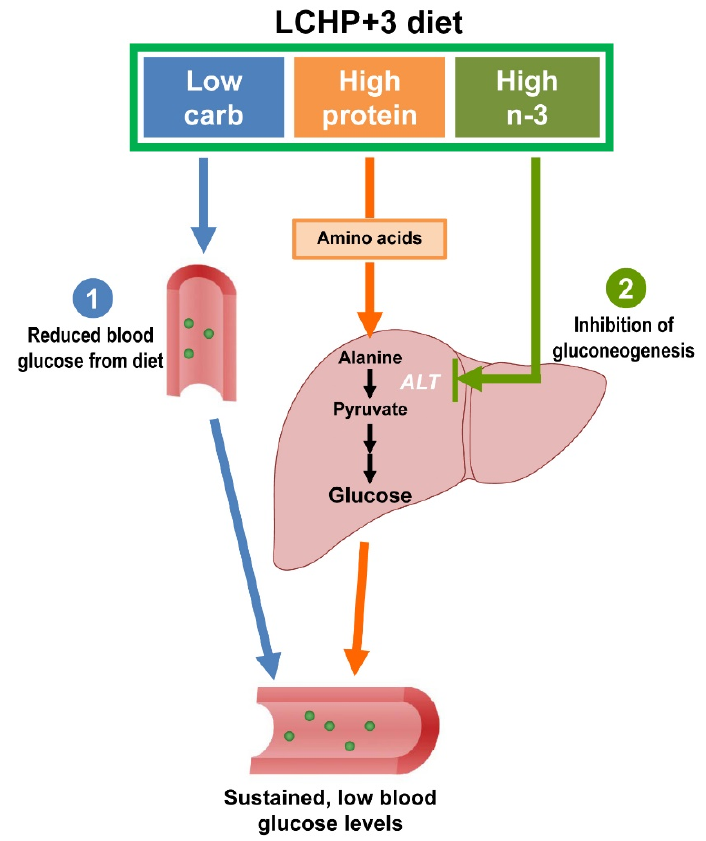
Figure 5. Schema of the potential mechanisms underlying the sustained, blood glucose-lowering effects of the LCHP+3 diet. (1) By reducing exogenous sources of glucose by low-carbohydrate intake; and (2) by inhibiting the endogenous synthesis of glucose through the reduction of protein gluconeogenesis. Blue, orange and green arrows represent the possible role and mechanism of low carbohydrate, high protein and high omega-3 in the glucose-lowering effect of LCHP+3 diet, respectively.